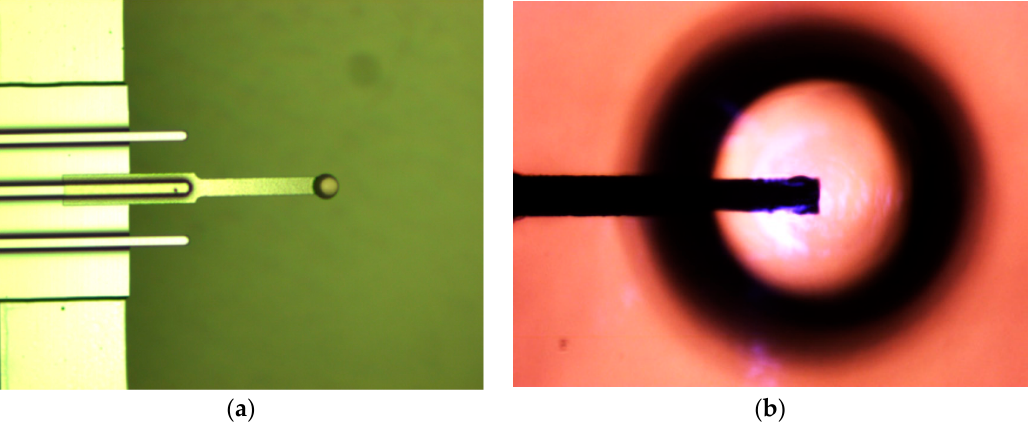
Figure 3. Colloidal probe of hydrophilic glass microsphere ( a ); Snapshot of bubble-particle interaction ( b